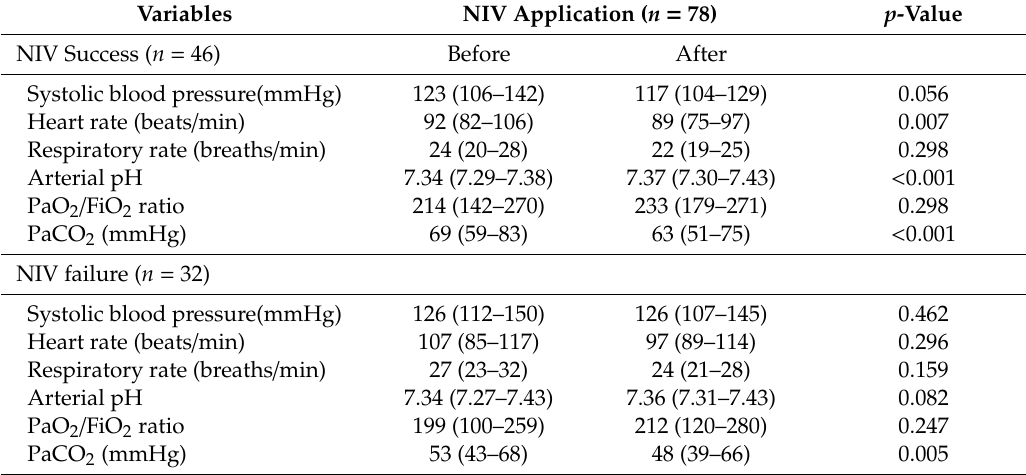
Table 6. Changes in physiological parameters after NIV